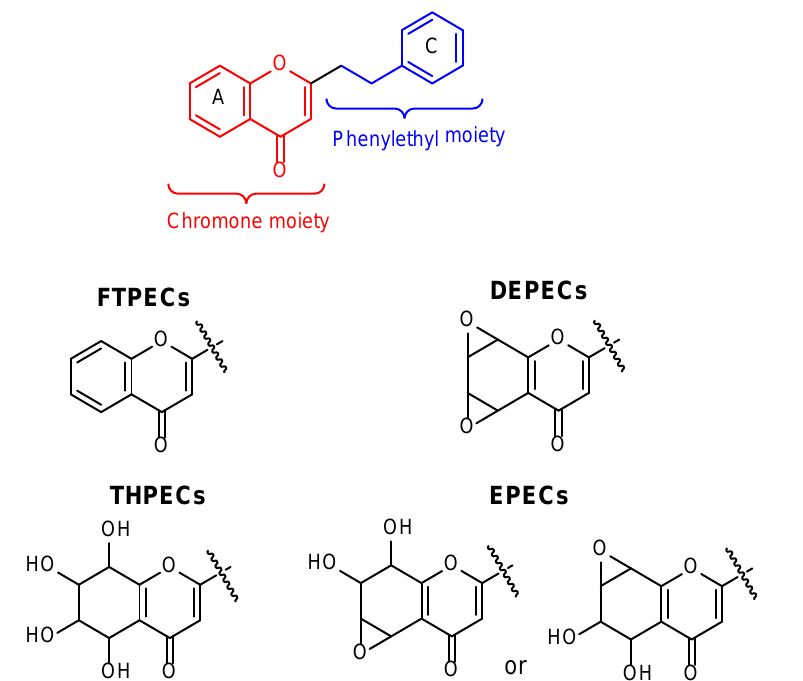
Figure 2. The characteristic structures of four types of 2-(2-phenylethyl)chromones.